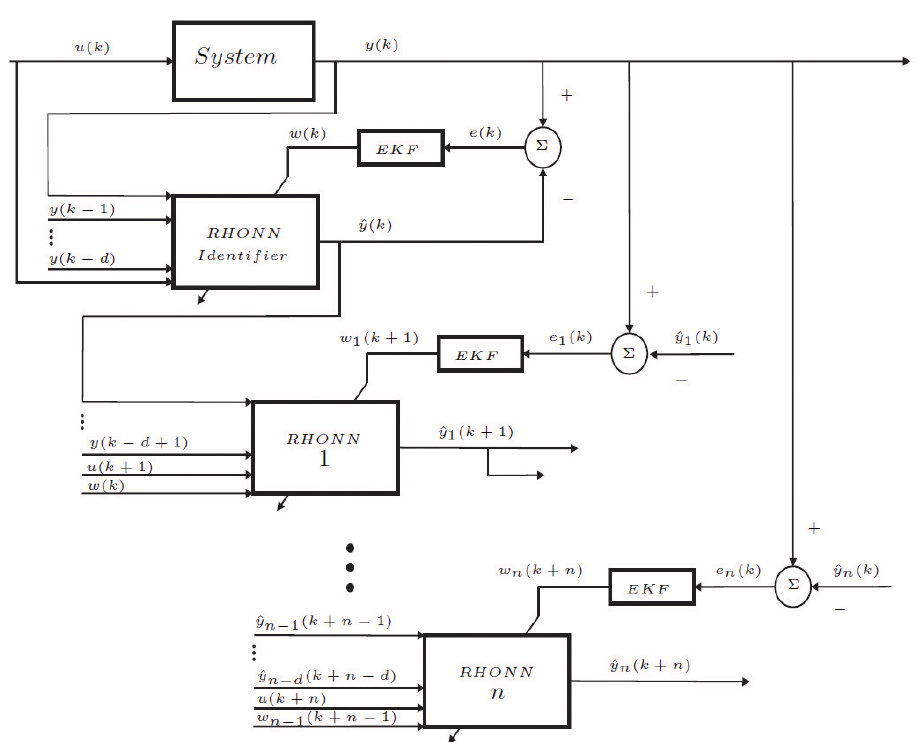
Figure 1. Multi-step-ahead forecasting